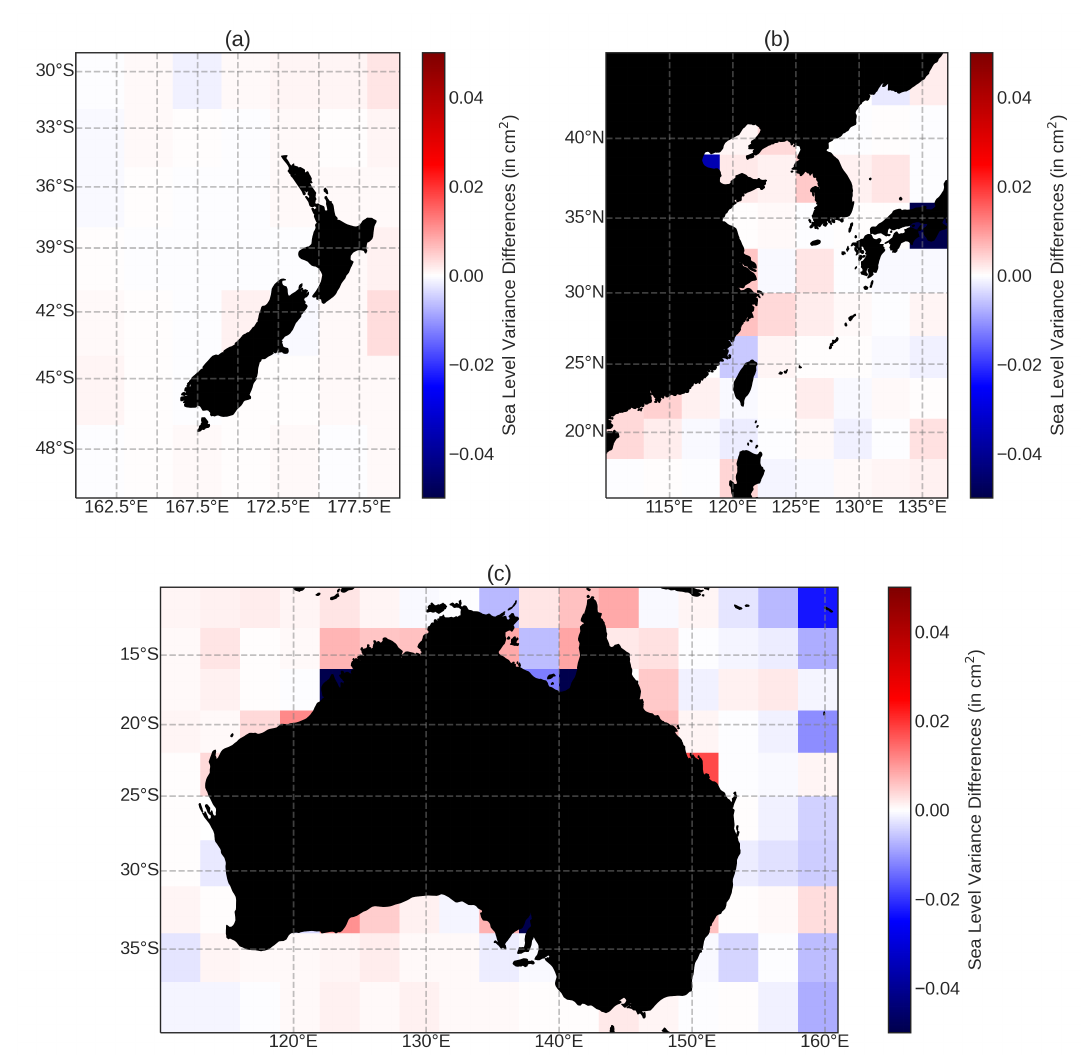
Figure 8. The sea-level variance differences between EOT-R and EOT-H for ( a ) New Zealand, ( b ) the Yellow Sea and ( c ) Australia. Please note the adjusted color bar compared to Figures 5–7. Here, when the regions are colored red, EOT-R shows a reduction in SLA variance, while the opposite is the case in blue